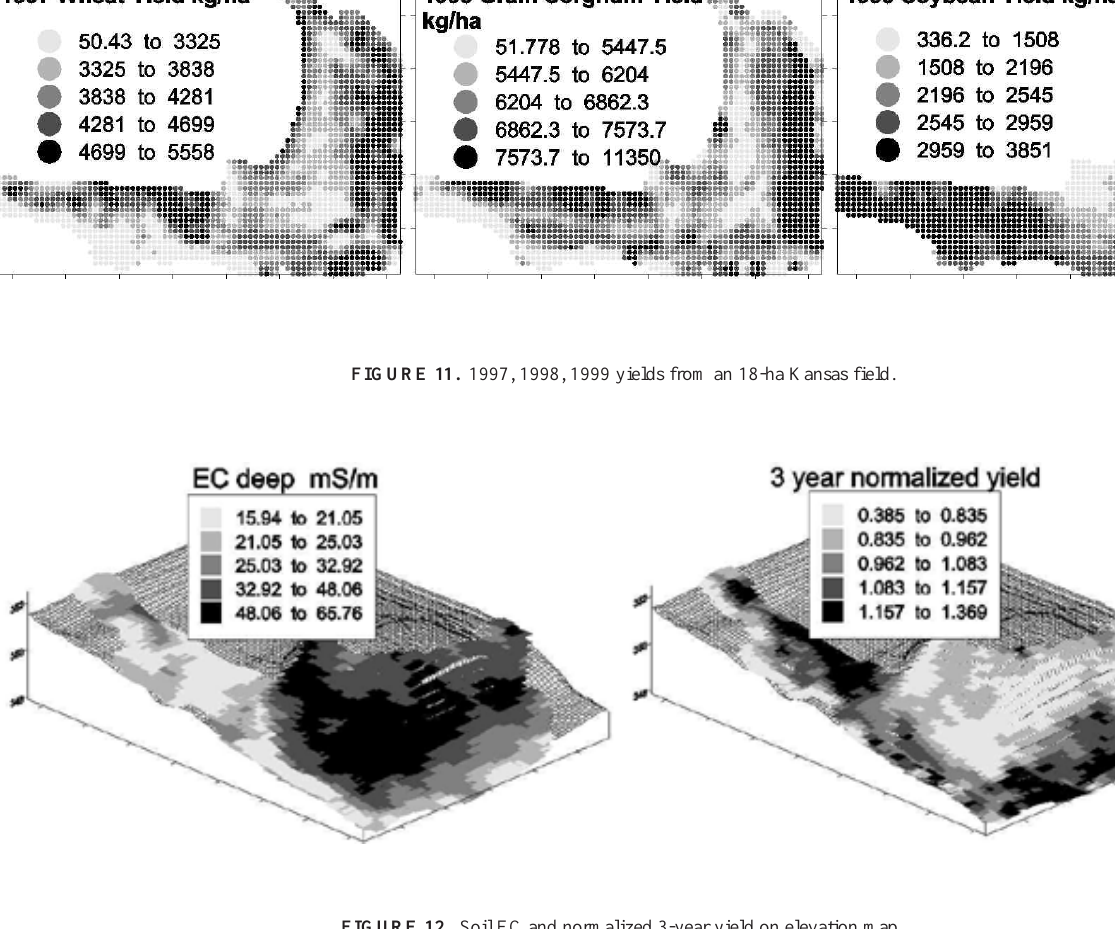
FIGURE 12. Soil EC and normalized 3-year yield on elevation map.